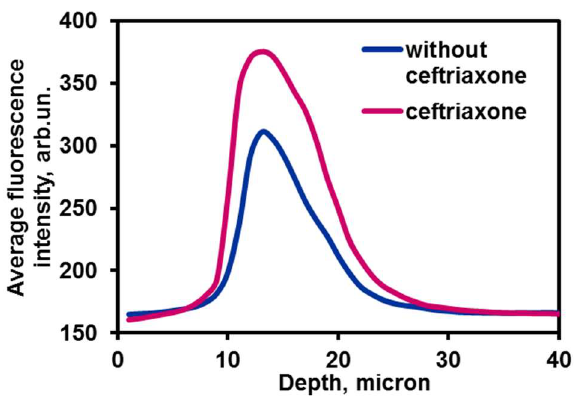
Figure 11. Intensity of channel 2 for the cell samples incubated with maleated chitosan containers as a function of depth obtained by CLSM Z-stack profiling. a function of depth obtained by CLSM Z-stack